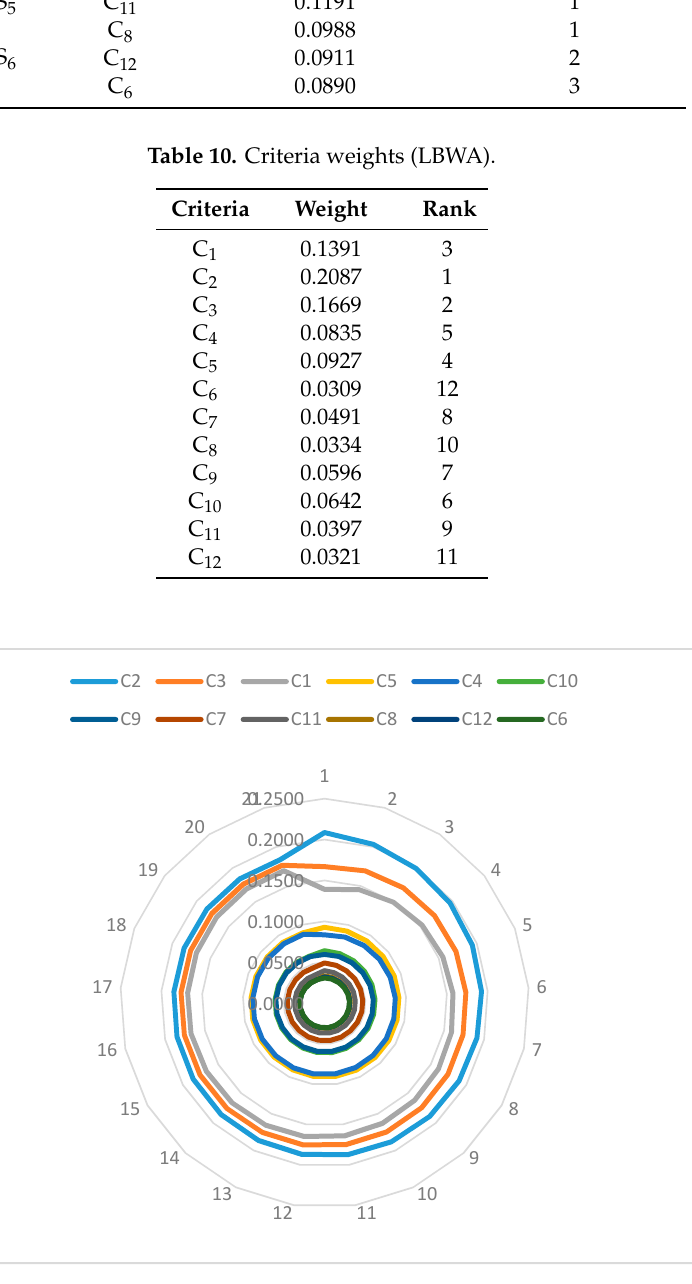
Figure 1. Sensitivity analysis (LBWA). Table 11. Response of the first member of the educators/executives (EE) panel.